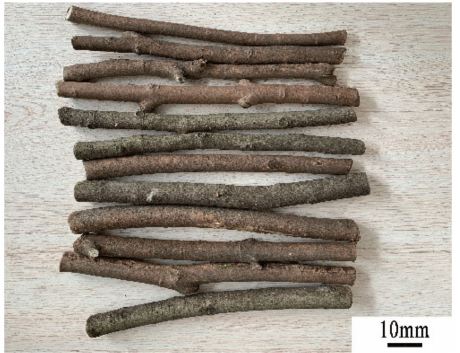
Figure 3. Branch